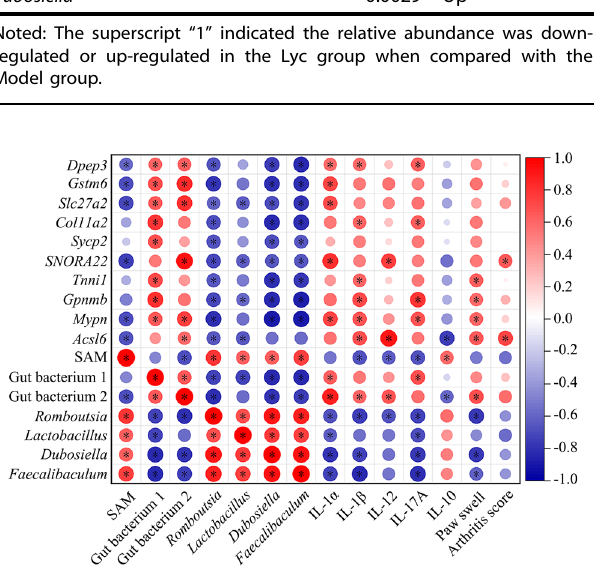
Fig. 4 Correlation heatmap among the joint status, the contents of SAM and cytokines, the abundances of speci fi c gut bacteria and the FPKM value of differentially expressed genes. Noted that, Gut bacterium 1 represents the uncultured_bacterium_f_ Rumino- coccaceae ; Gut bacterium 2 represents the Lachnospiraceae _ NK4A1 36